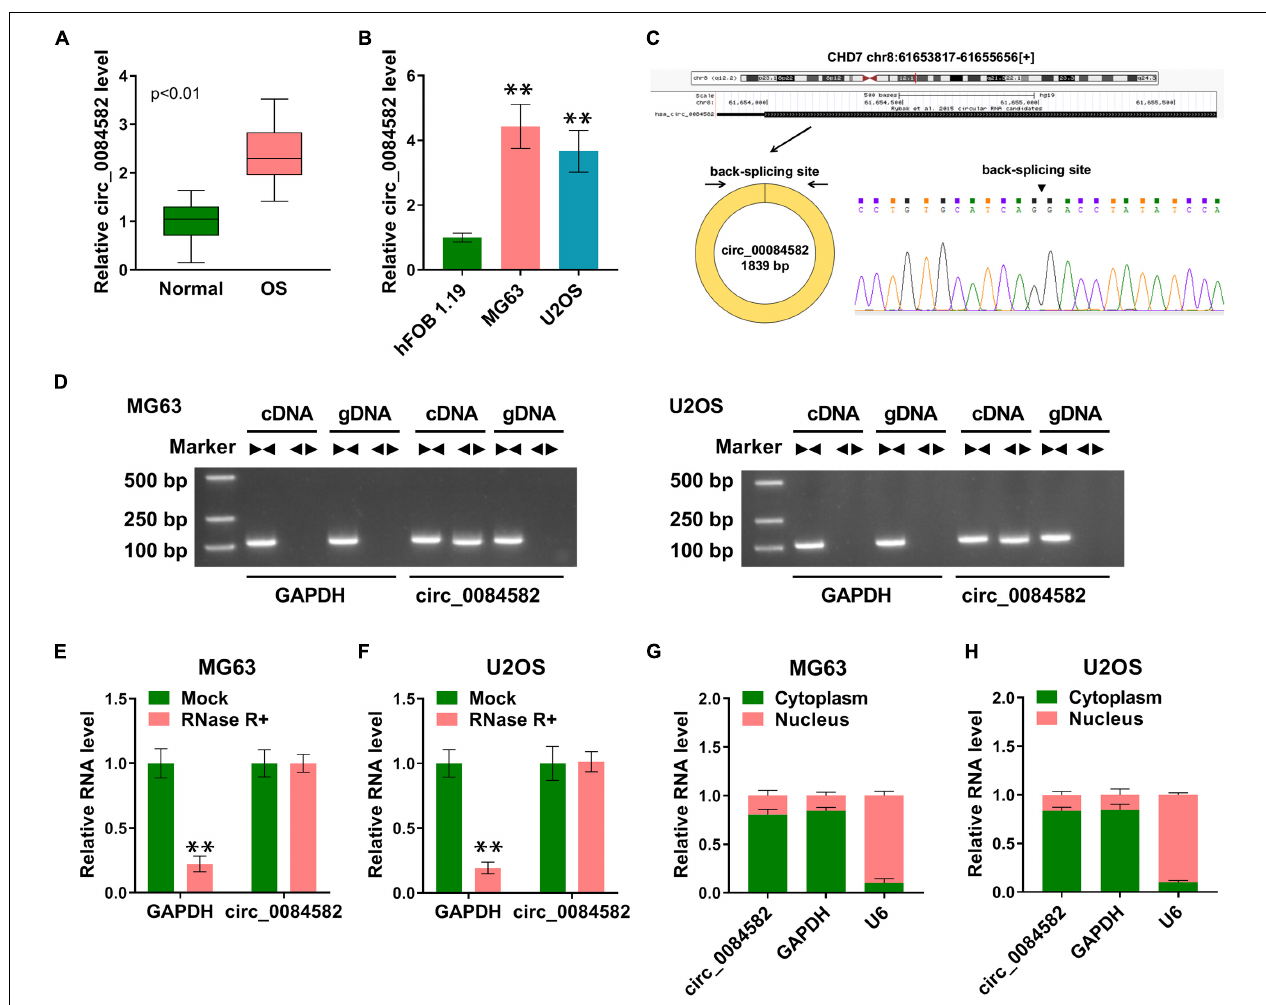
FIGURE 1 | High expression of circ_0084582 is found in OS tissues and cells. (A,B) The expression of circ_0084582 is examined by qRT-PCR in OS tissues (A) and cells (B) . (C) The back-splicing bites of circ_0084582. (D) Circ_0084582 and linear GAPDH are distinguished by gel electrophoresis. (E,F) GAPDH and circ_0084582 levels are examined by qRT-PCR in RNase R and Mock groups. (G,H) The qRT-PCR is used for the detection of circ_0084582, GAPDH, and U6 in cytoplasm and nucleus. All experiments were performed with three biological replications. ∗∗ P < 0.01.